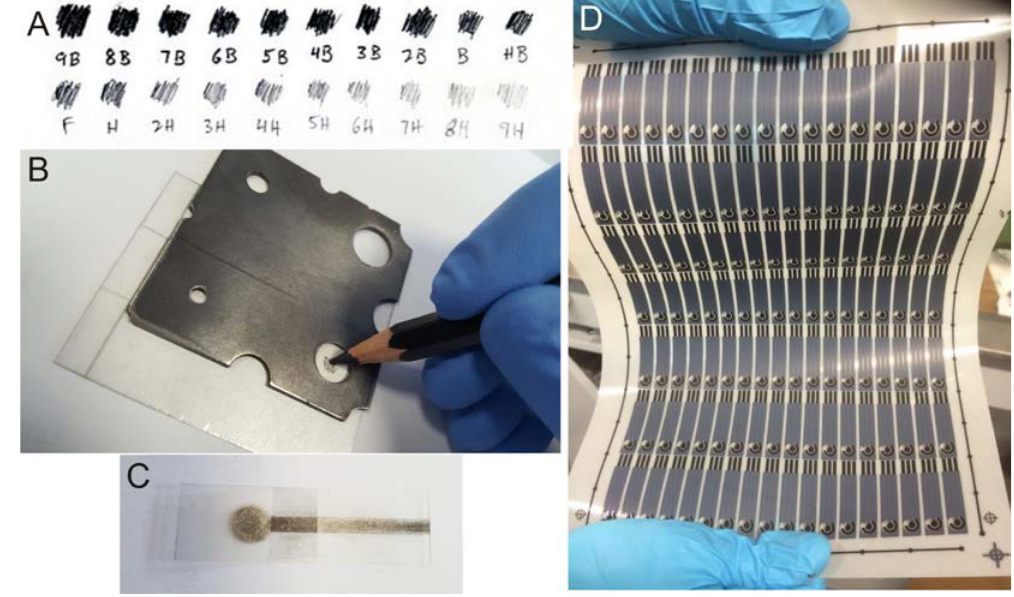
Figure 1. Different pencil grades and their graphite deposition ( A ), fabrication of Pencil-drawn Electrodes ( B ), a typical final Pencil-drawn Electrode ( C ) and an image of a sheet of screen-printed electrodes fabricated via the screen-printing process ( D ).